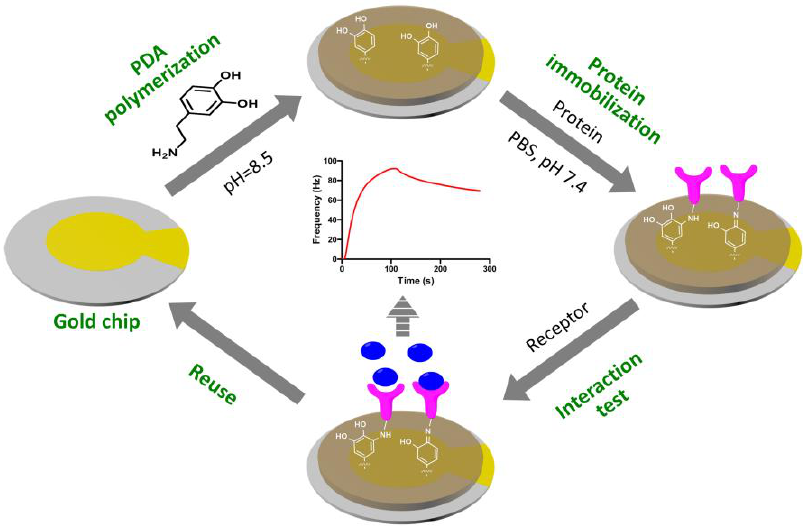
Figure 2. Schematic illustration of the QCM biosensor based on polydopamine surface.